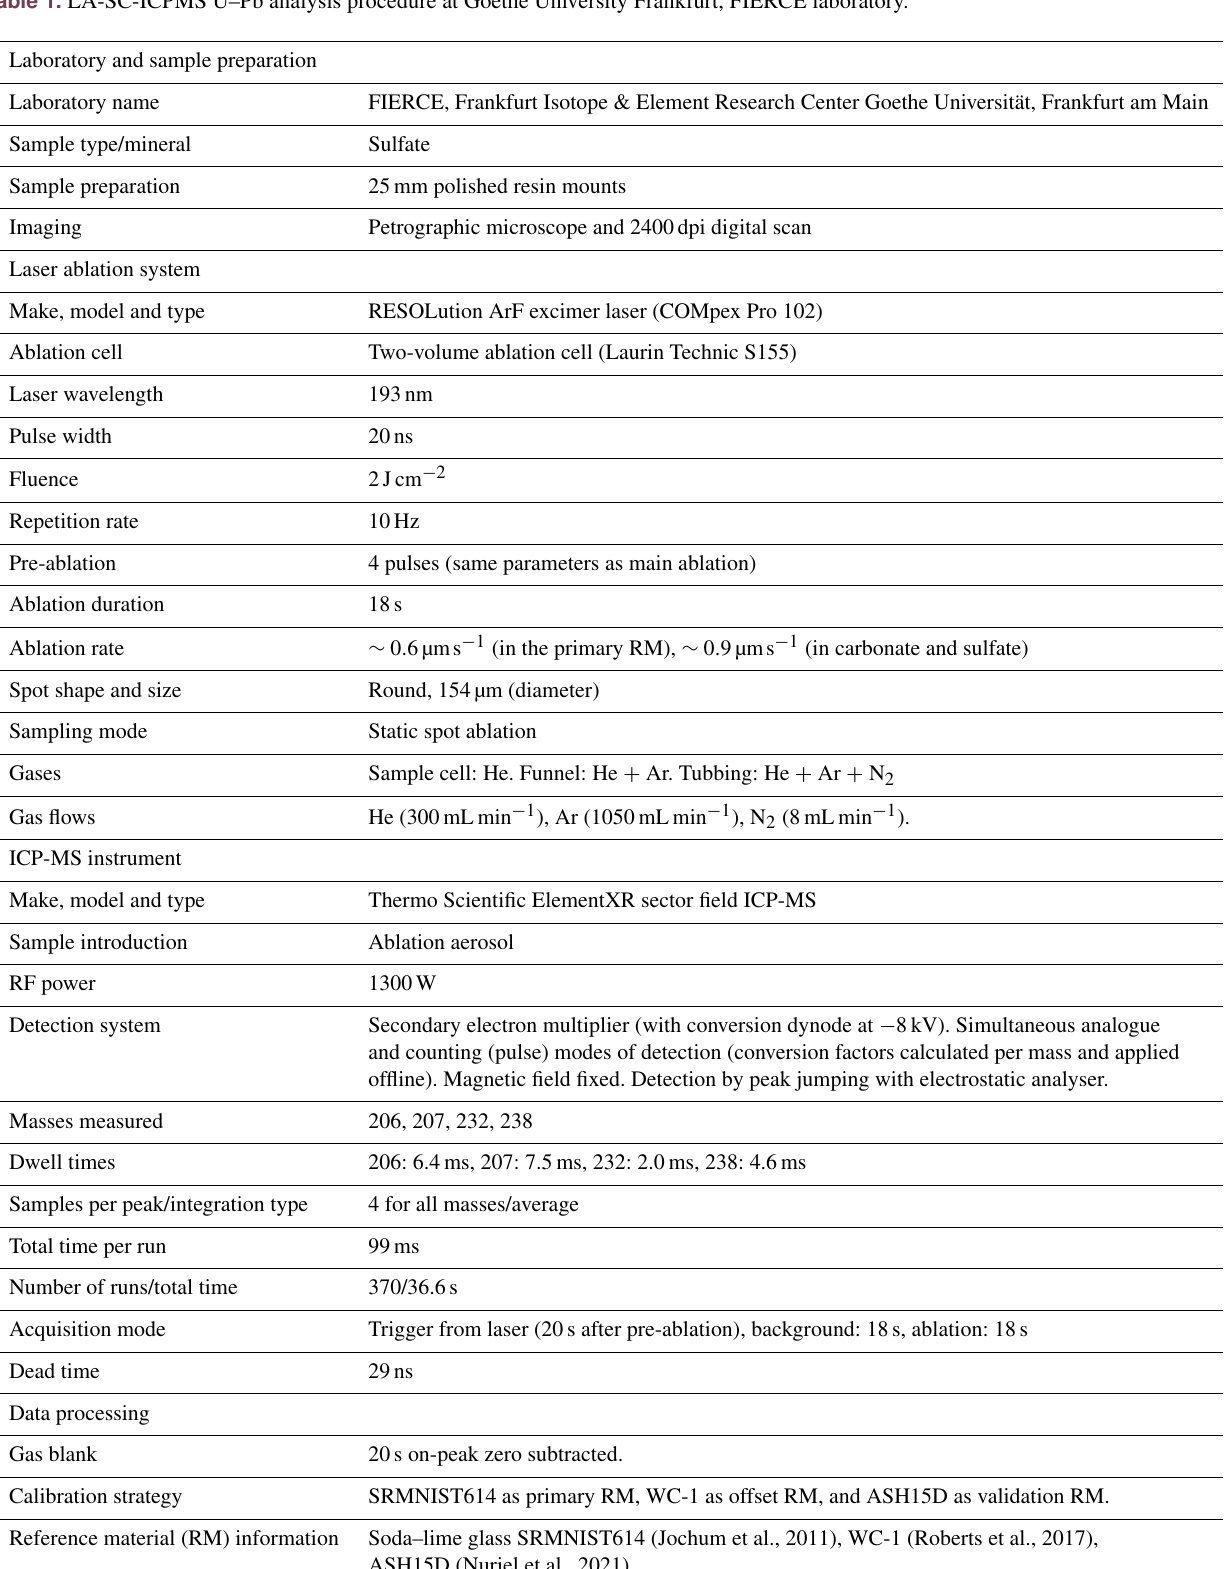
Table 1. LA-SC-ICPMS U–Pb analysis procedure at Goethe University Frankfurt, FIERCE laboratory. Laboratory and sample